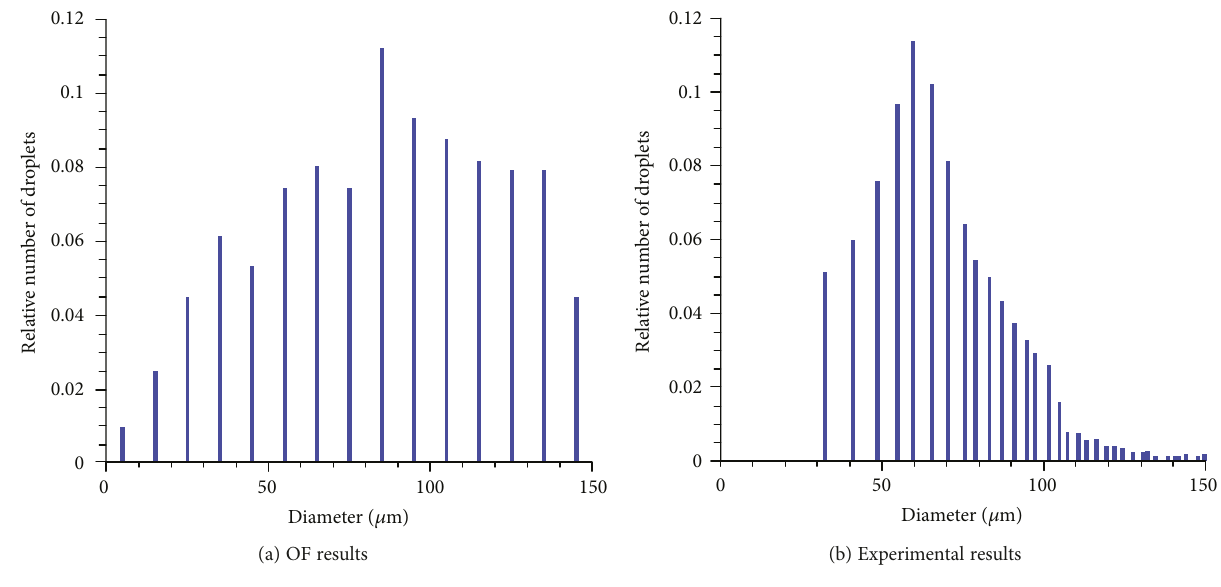
Figure 17: Relative number of droplet